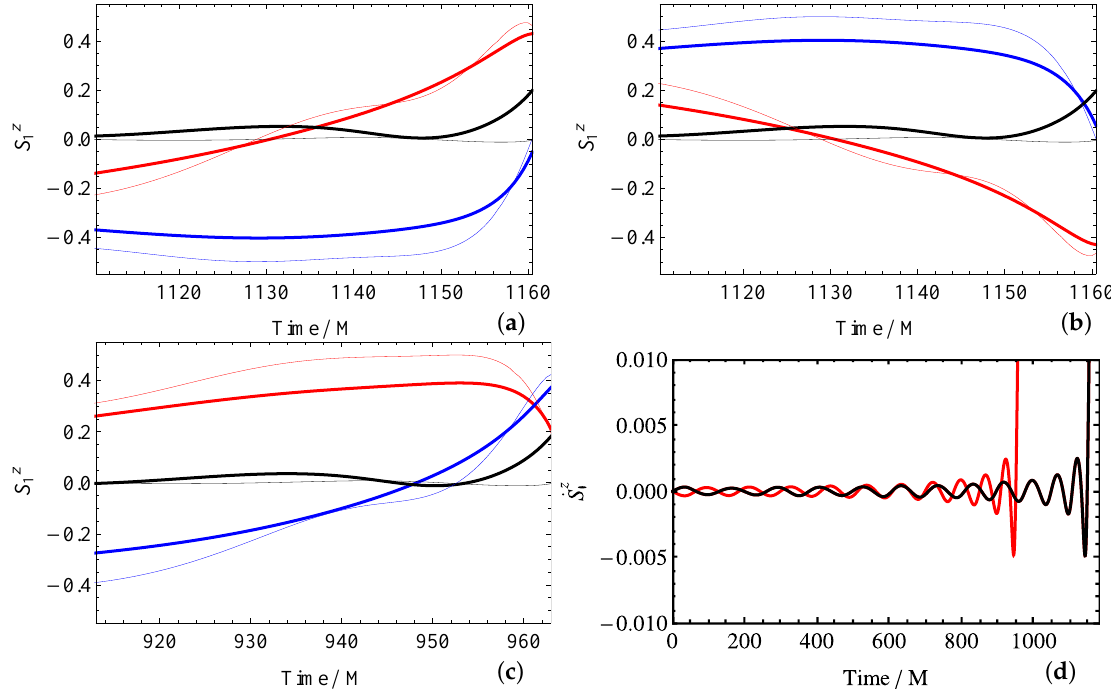
Figure 6. The analytically predicted (thick lines) vs. the numerically computed (thin lines) S 1 for the SK ( a ), SK- ( b ) and SK ⊥ ( c ) simulations. The red, blue and black lines correspond to S x respectively. We focus on the last 50M before merger. Panel ( d ) shows the analytical predictions for ˙ S z of the SK / SK- (both correspond to the black curve) and the SK ⊥ (red curve)